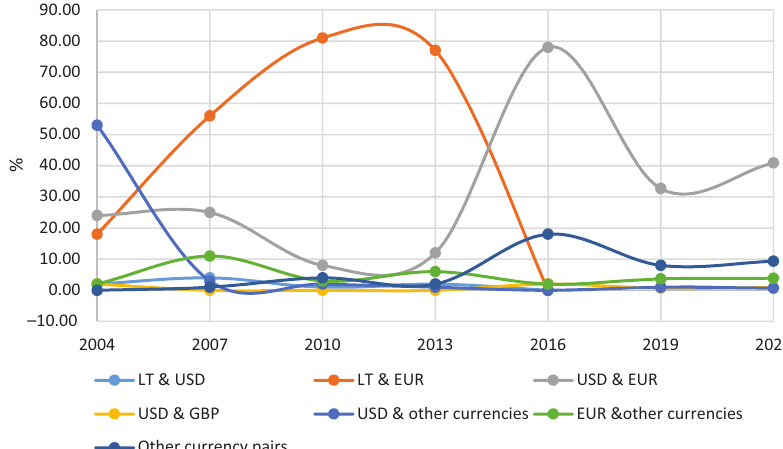
Figure 11. Forecast of currency pairs according to the weighted moving average method (source: developed by the authors based on LB, 2016, 2018, 2019b; BIS, 2018a, 2018b) As the USD/EUR pair stands out in terms of value and percentage, its forecasting using various functions, such as exponential, linear, logarithmic, polynomial, power, etc., was car- ried out. Upon analysing the obtained results and graphs according to various functions, the function with the highest coefficient of determination, and thus the correlation coefficient, i.e., R 2 = 0.7982 (Figure 12), was selected for forecasting purposes. The trends in the USD/ EUR pair forecasted by applying a polynomial function show a significant increase in the percentage of this pair in the future. The forecast carried out according to the weighted mov- ing average method also projects a future upward trend, though less